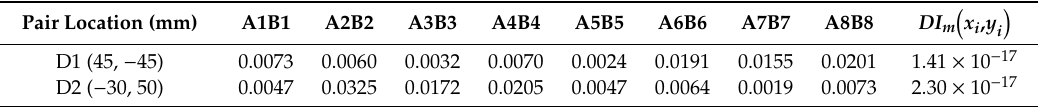
Table 1. Possibilities of damage existence values at damage locations from all sensing pairs in pulse–echo configuration.